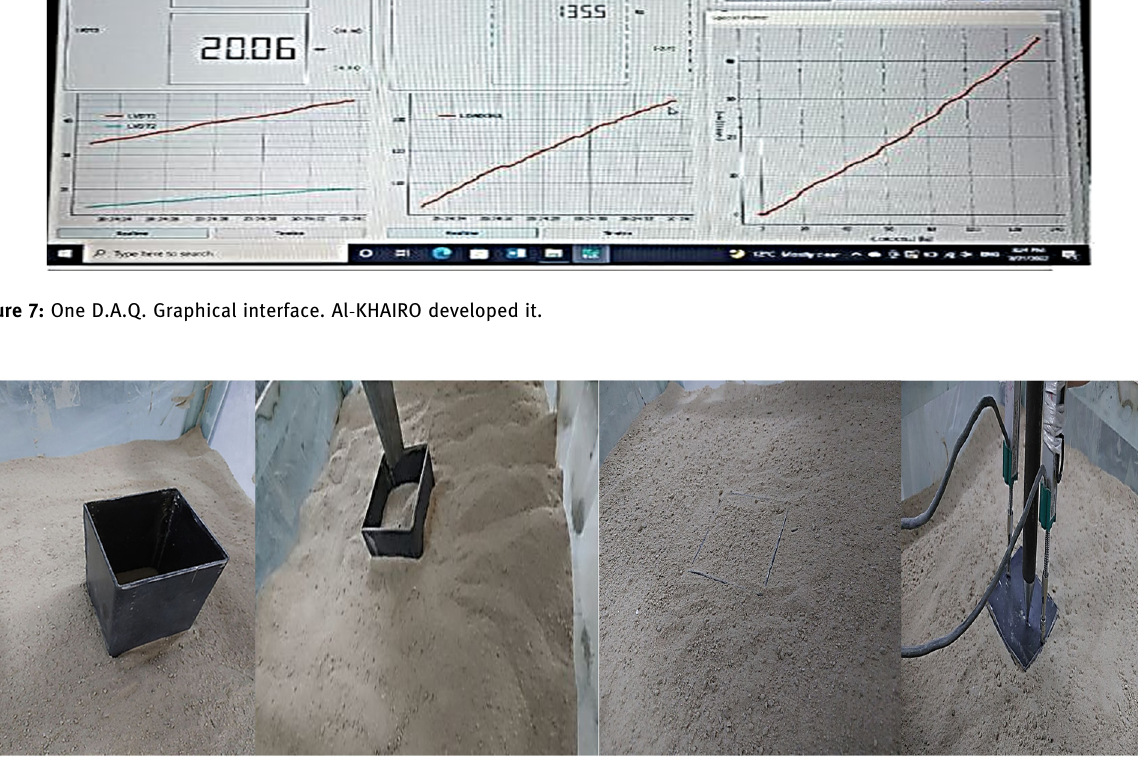
Figure 8: Steps of soil preparation and skirt foundation placement.